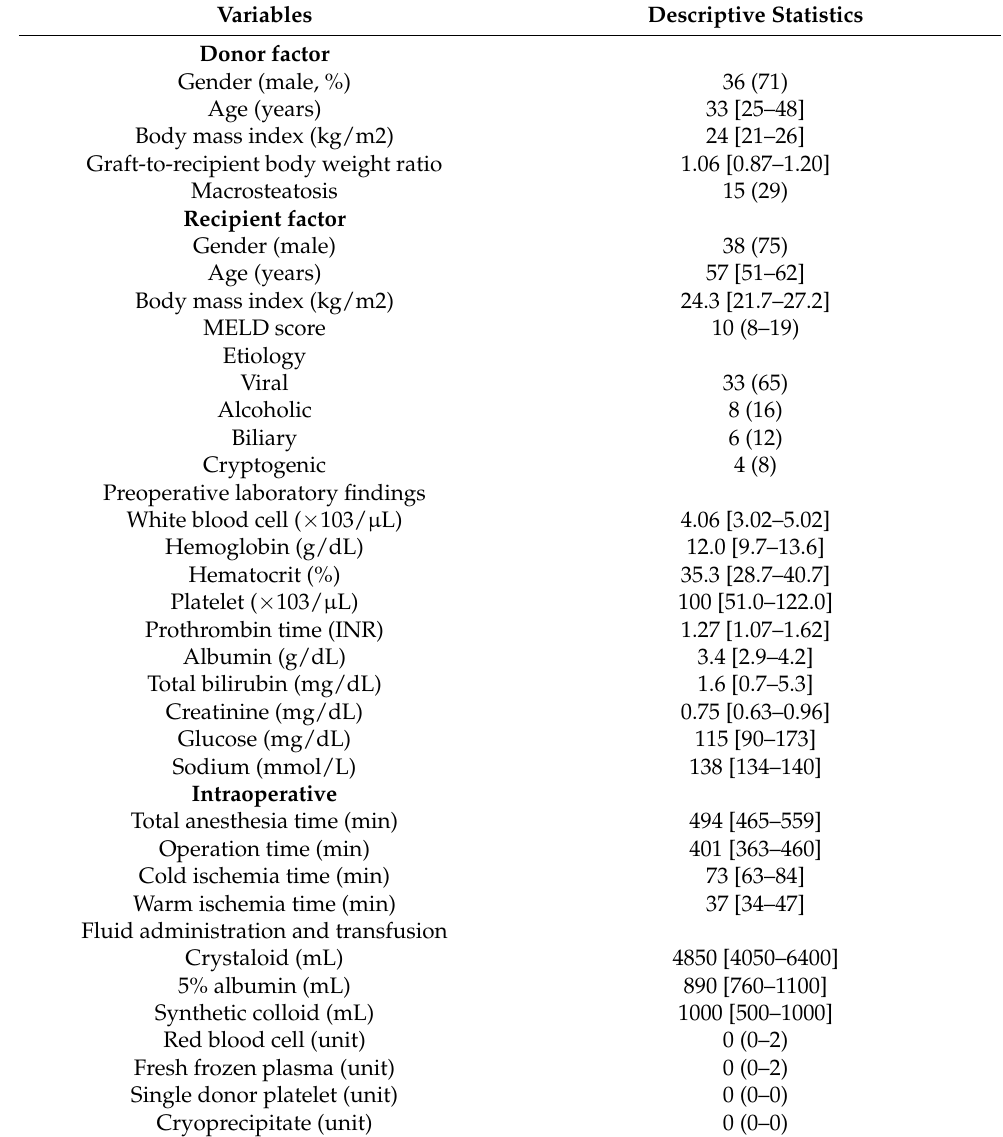
Table 1. Patients